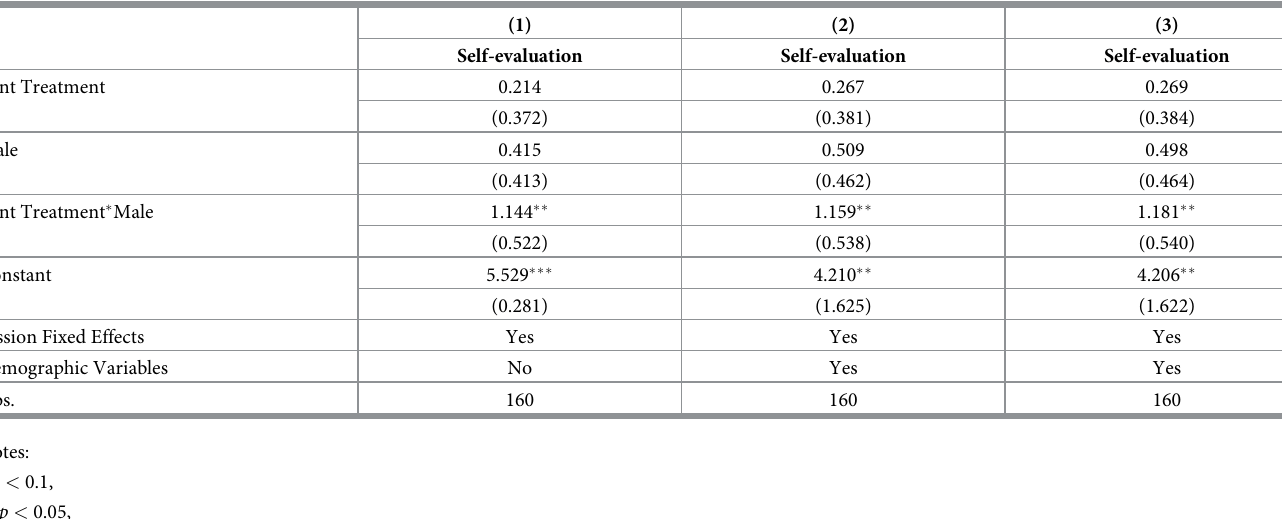
Table 7. Difference-in-difference estimates of gender gaps in self-reported